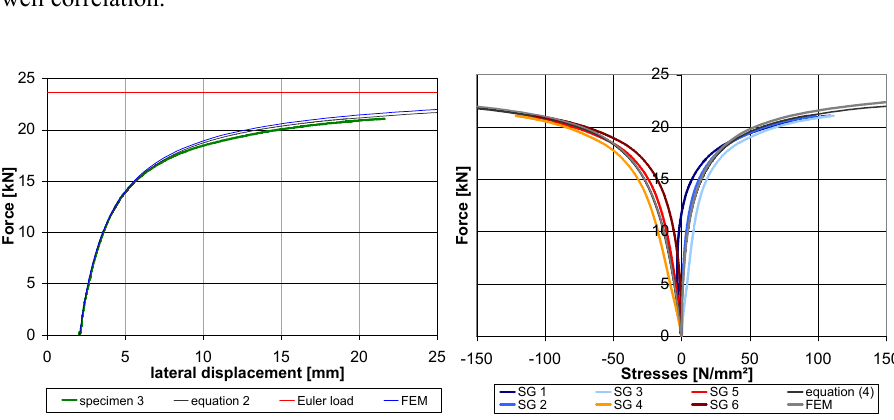
Figure 6: Example: experimental force-displacement-curve (left) and force-stress-curve (right) for the test specimen No. 3 including the analytical and numerical